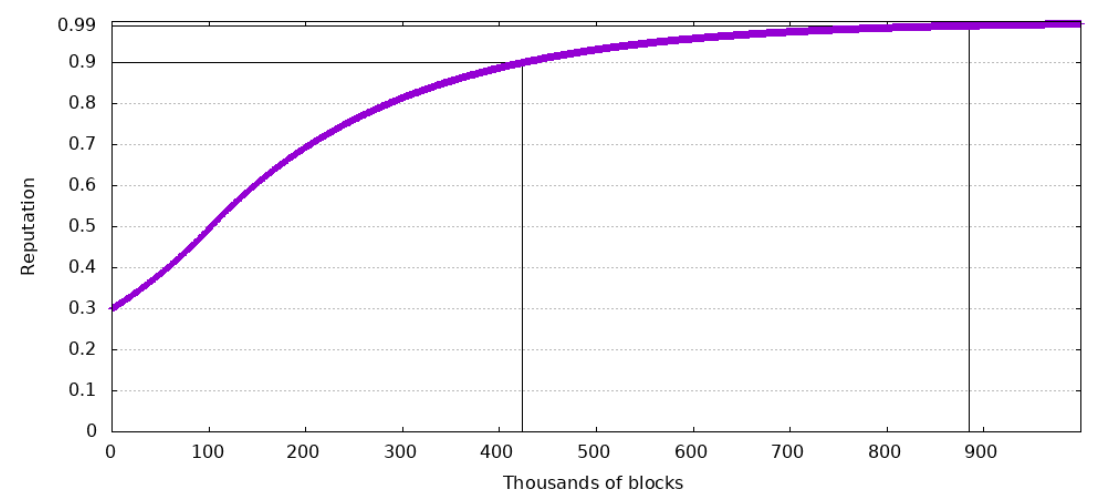
Figure 8. Reputation change over time (speedCoefficient = 1 × 10 − 5 ).